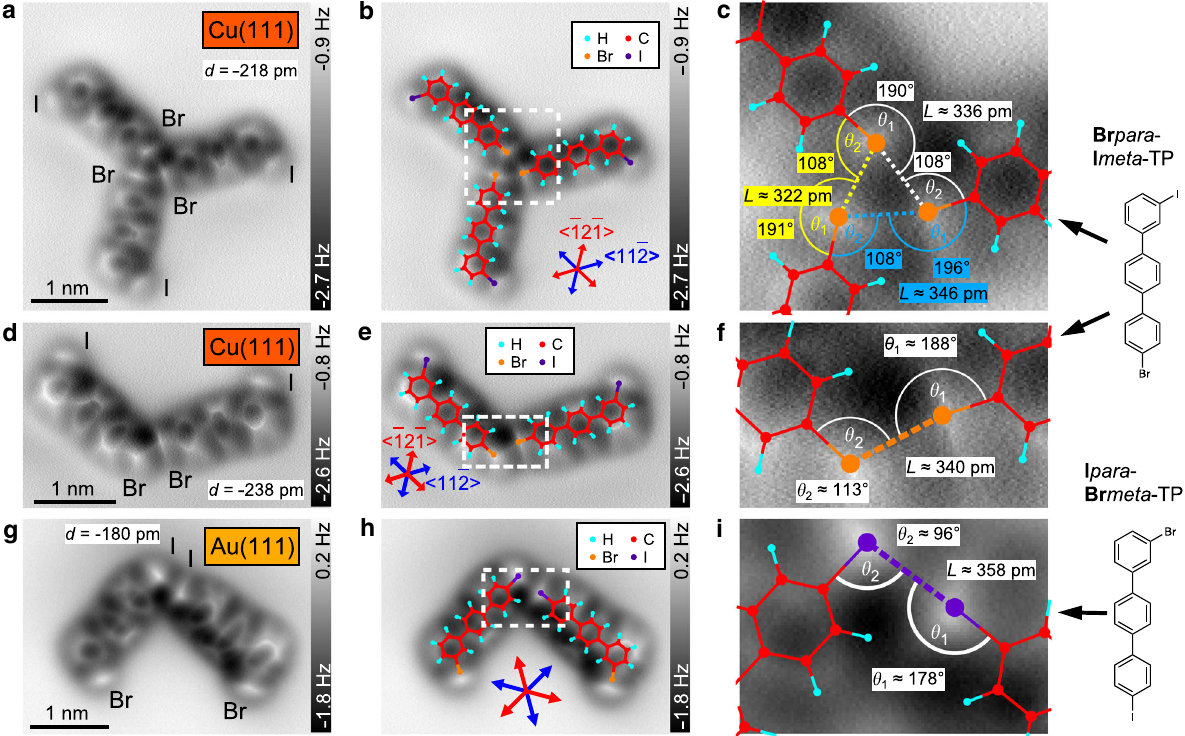
Fig. 3 Bonding con fi gurations of typical windmills and dimers on Cu(111) and Au(111). a – c AFM constant-height images of a Br···Br···Br windmill structure of Br para I meta -TP on Cu(111). b AFM image overlaid with structural models of Br para I meta -TP. Crystallographic [ (cid:1) 12 (cid:1) 1] and [11 (cid:1) 2] directions of the Cu(111) lattice are indicated with red and blue arrows, respectively. c Zoom-in to central region of the cluster with bonding angles θ 1 and θ 2 and bond distance L of the halogen bonds. Each bromine is acting as a halogen bond donor and acceptor, respectively (see Fig. 1b). d – f AFM image and bonding con fi guration of a Br···Br dimer [ Br para I meta -TP on Cu(111)]. g – i AFM image and bonding con fi guration of a I···I dimer [ I para Br meta -TP on Au(111)]. Parameters: oscillation amplitude 160pm